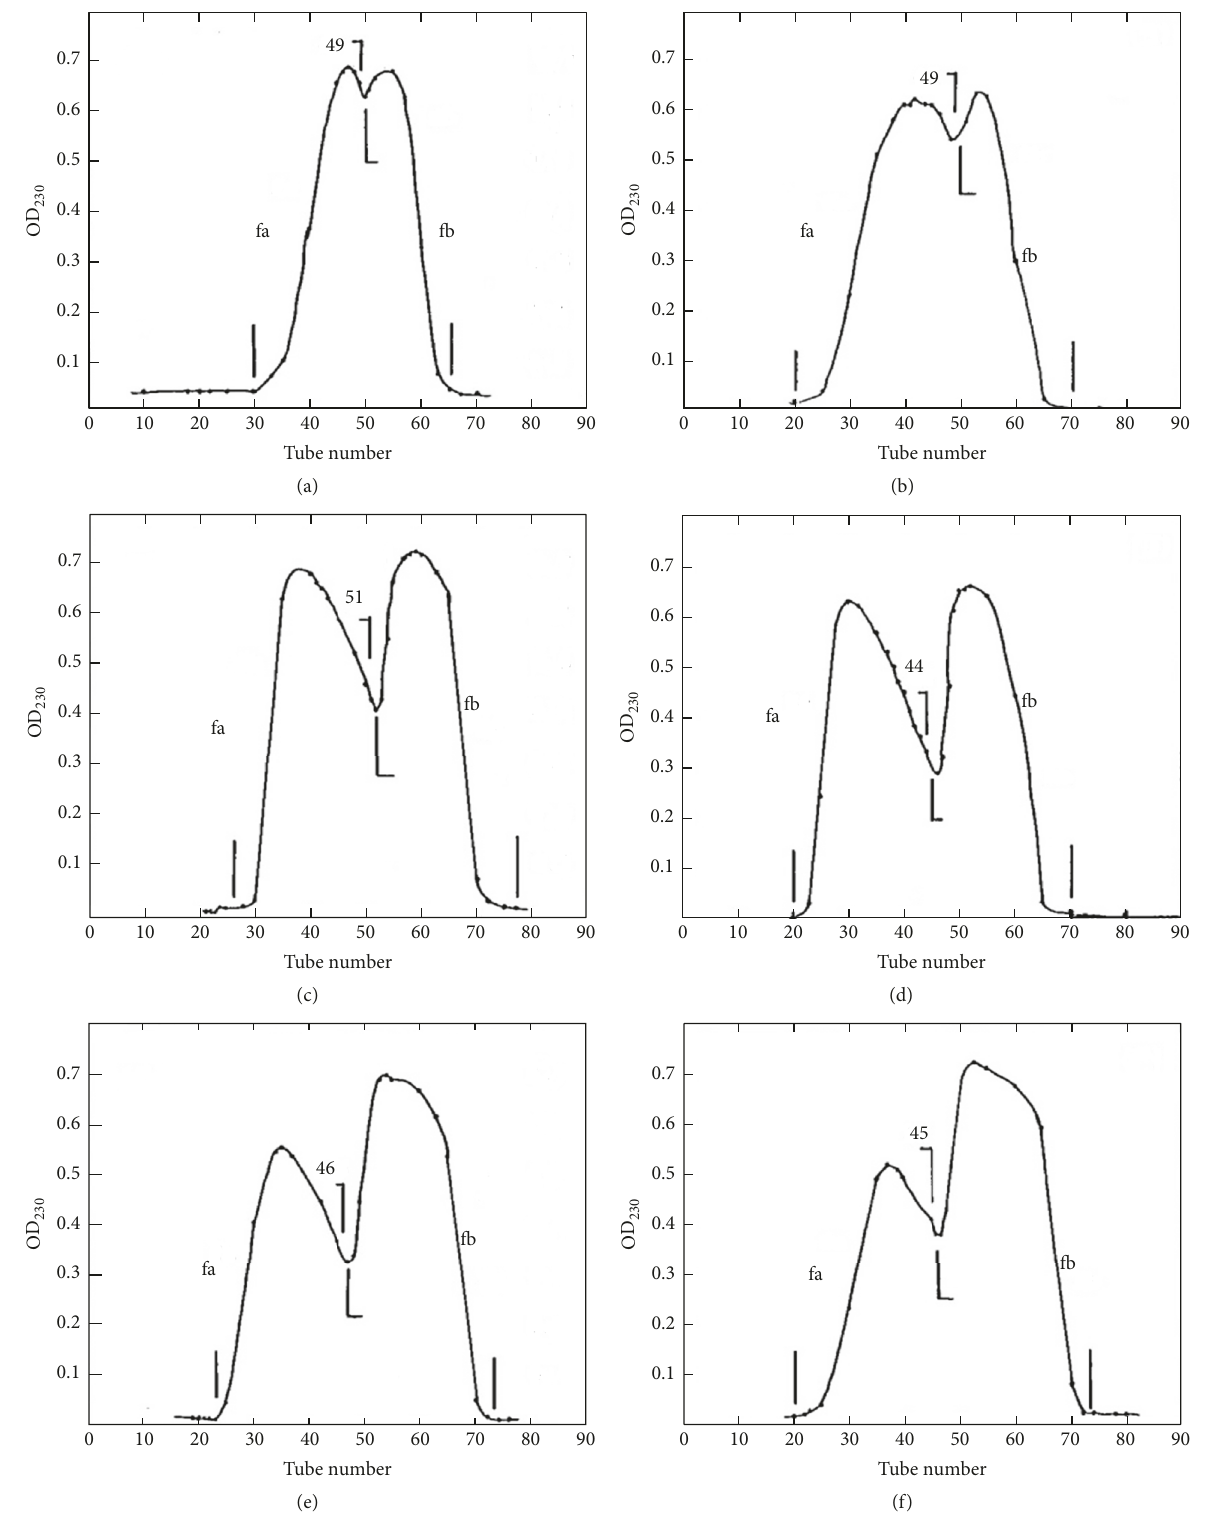
Figure 7: Gel permeation chromatograms of the reaction mixtures of Boc-Gly-L-Asp at 130 ∘ C for varying reaction times: (a) 1h; (b) 2h; (c) 4 h; (d) 8h; (e) 16h; and (f) 24h. Solid phase: Sephadex G-25F. Eluate: 0.5 M acetic acid. Volume per test tube: 3 mL. fa: ninhydrin-negative, higher molecular weight fractions; fb: ninhydrin-positive lower molecular weight